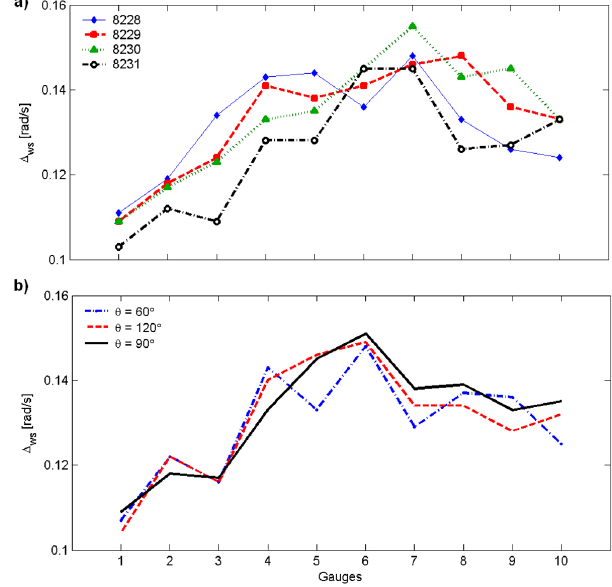
Figure 7. Changes in the width of the wind sea spectral component with the distance for: (a) following; (b) crossing mixed